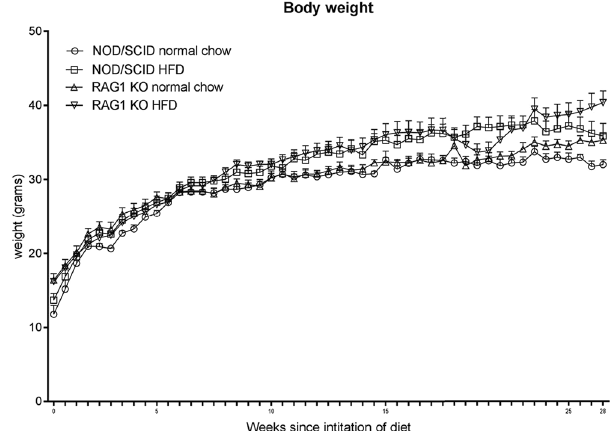
Figure 2. Mean body weight in NOD/SCID and Rag1 − / − mice fed a high-fat diet (HFD) (23% fat, n = 8) compared to normal low-fat chow-fed control groups (n = 4). Mean +